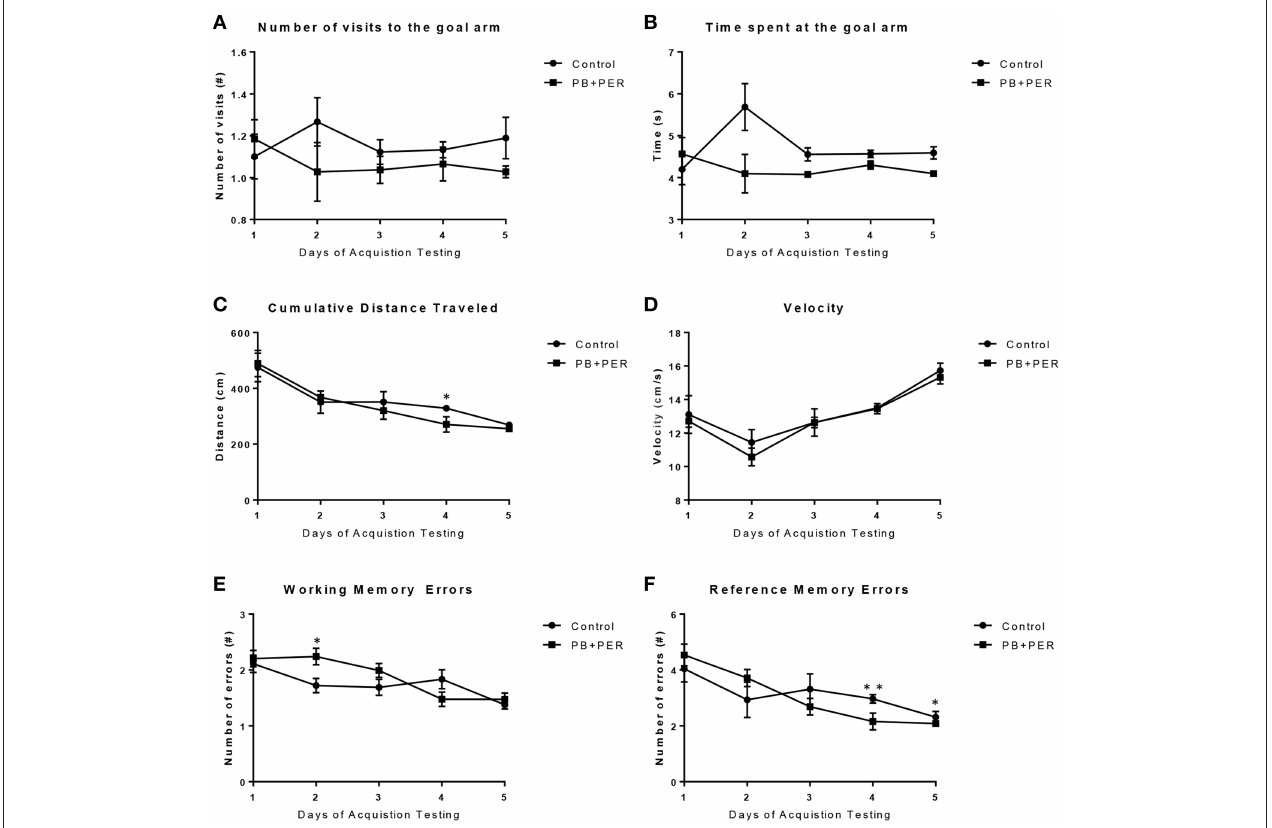
FIGURE 4 | Acute exercise may improve working and reference memory in exposed mice during RAWM acquisition testing, 13 months post exposure. When examining (A) the Goal Arm Frequency (#), the number of times the mice entered the goal arm, and (B) the duration at the goal arm (s), no overall differences were observed between control and PB + PER mice. When examining (C) the cumulative distance traveled, a difference was noted on Day 4 between control and PB + PER mice, where PB + PER mice outperformed the control mice. No differences were noted when examining their (D) velocities by day. In addition, when examining (E) the number of working memory errors made by either the exposed mice or the control mice over the 5 day testing period at 13 months post exposure, differences were observed on day 2, where PB + PER mice made more errors as compared to controls. However, PB + PER exposed mice seemed to improve (make less errors) as they continued to advance through the acquisition days (E,F) . When examining (F) the number of reference memory errors, significant differences were observed between the two groups on days 4 and 5, where PB + PER mice performed better/on par with their control counterparts. Overall these data suggest